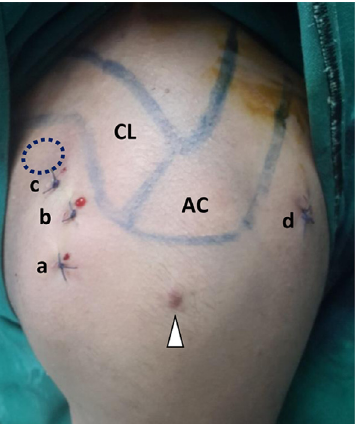
Figure 3. Postoperative image showing portals used for arthro- scopic approach to the base of coracoid (a and b) standard anterior portal, (c) additional anterior portal just lateral to coracoid process, (d) standard posterior portal, CL – clavicle, AC – acromion, arrowhead – previous arthroscopy scar, dotted circle – coracoid process.